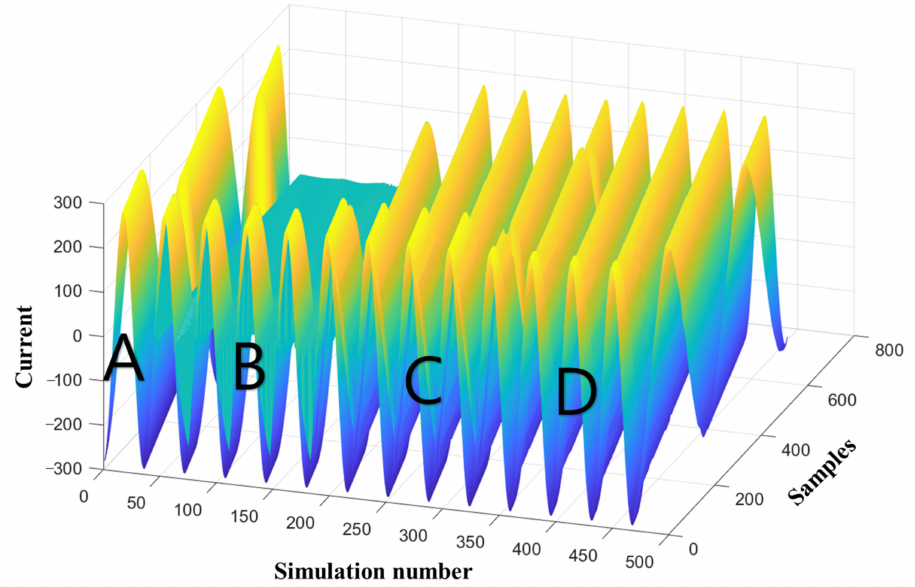
Figure 10. Phase A current by fault